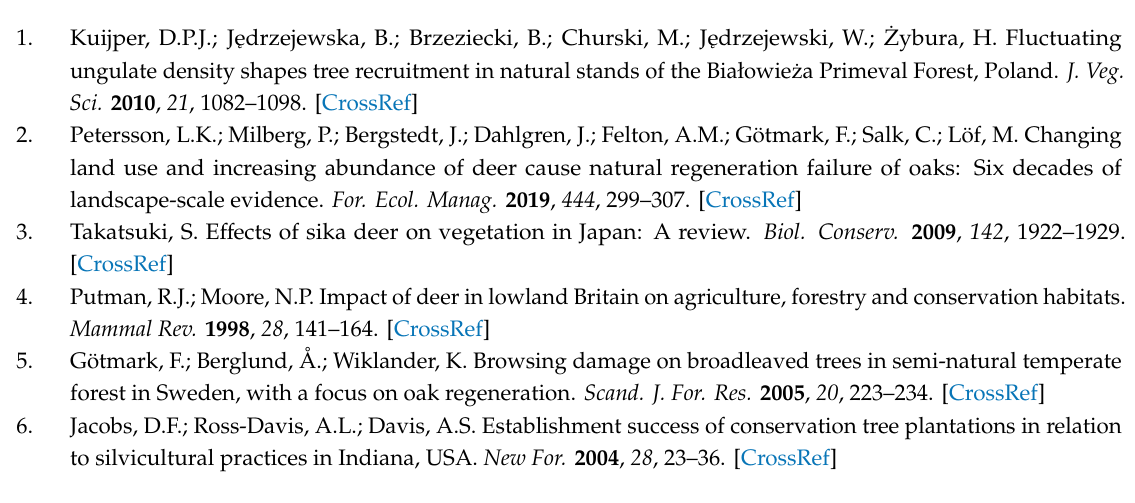
Table S1. Characteristics of the studies used in the meta-analysis. Includes ungulate and tree species studied, browse management methods used, number of years the study lasted, number of e ff ect sizes extracted from each study, and the type of responses. File: Studies Used in the